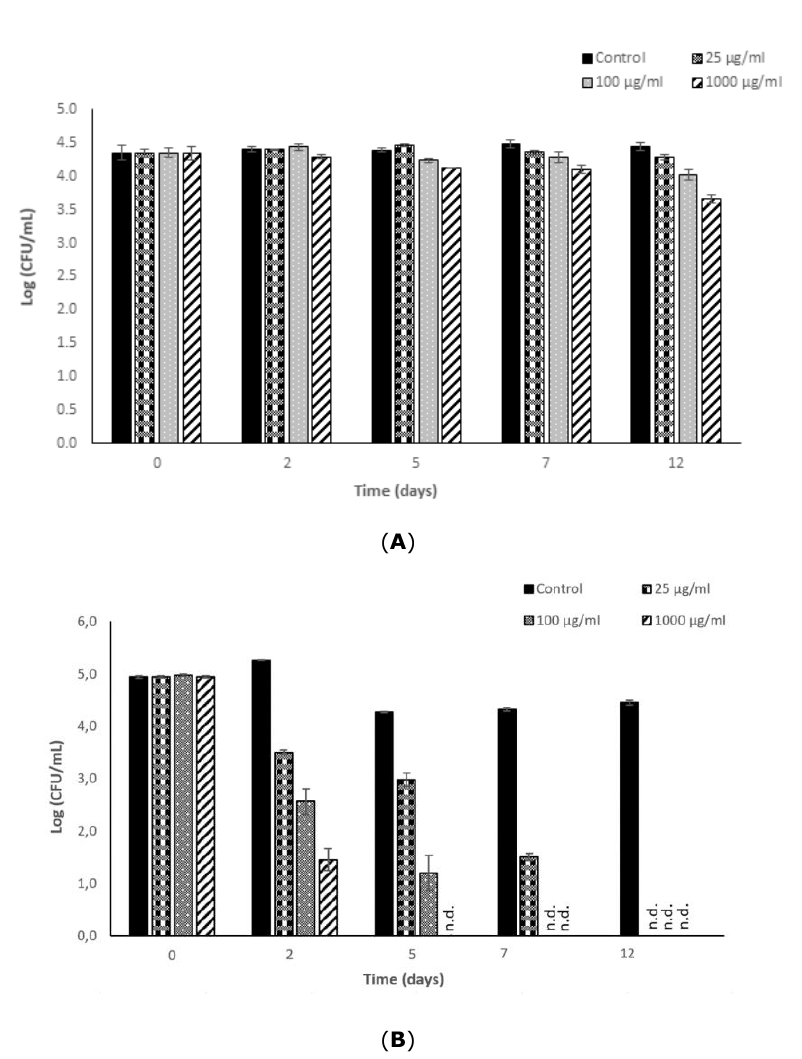
Figure 3. Antimicrobial potential of fucoidan from Fucus vesiculosus against Listeria monocytogenes ( A ) and Salmonella typhimurium ( B ) in a novel functional apple juice beverage stored at 8 °C for 12 days.